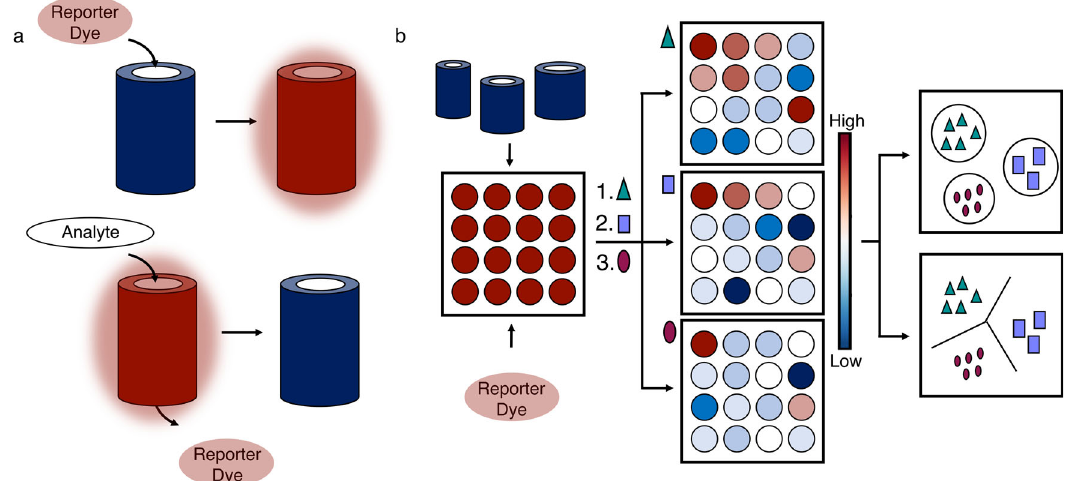
Fig. 1 | Concept for the de novo designed α -helical-barrel differential sensor. a Top: α -Helicalbarrels( α HBs)areloadedwithanenvironment-sensitivedyegiving a fl uorescent signal. Bottom: The dye is displaced by an analyte causing a loss of fl uorescence that can be measured. b Left: Different α HBs are combined with the environment sensitive dye in multi-well plates. Middle: The resulting array is chal- lengedwithdifferentanalytes,whichcanbepurecompoundsorcomplexmixtures.